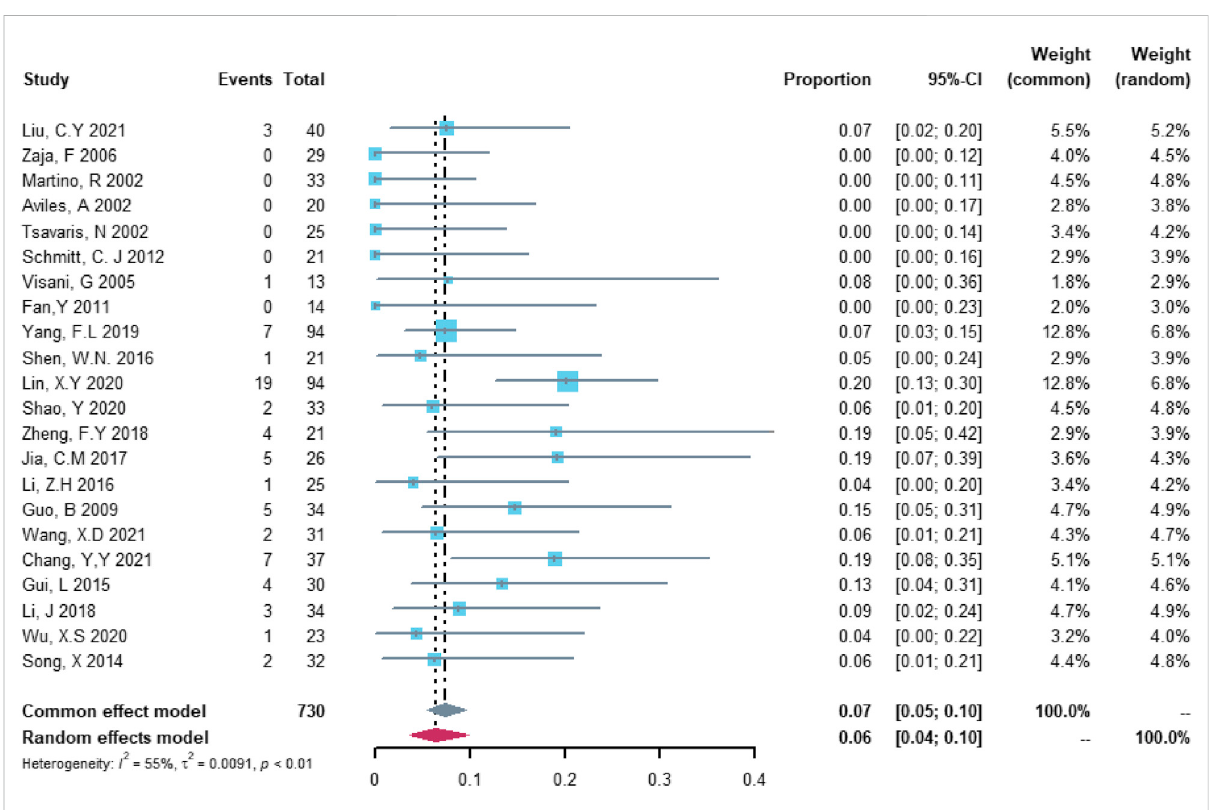
FIGURE 3 Summary pooled proportion analysis of non-serious cardiovascular adverse events associated with the (R)-CDOP combination regimen.